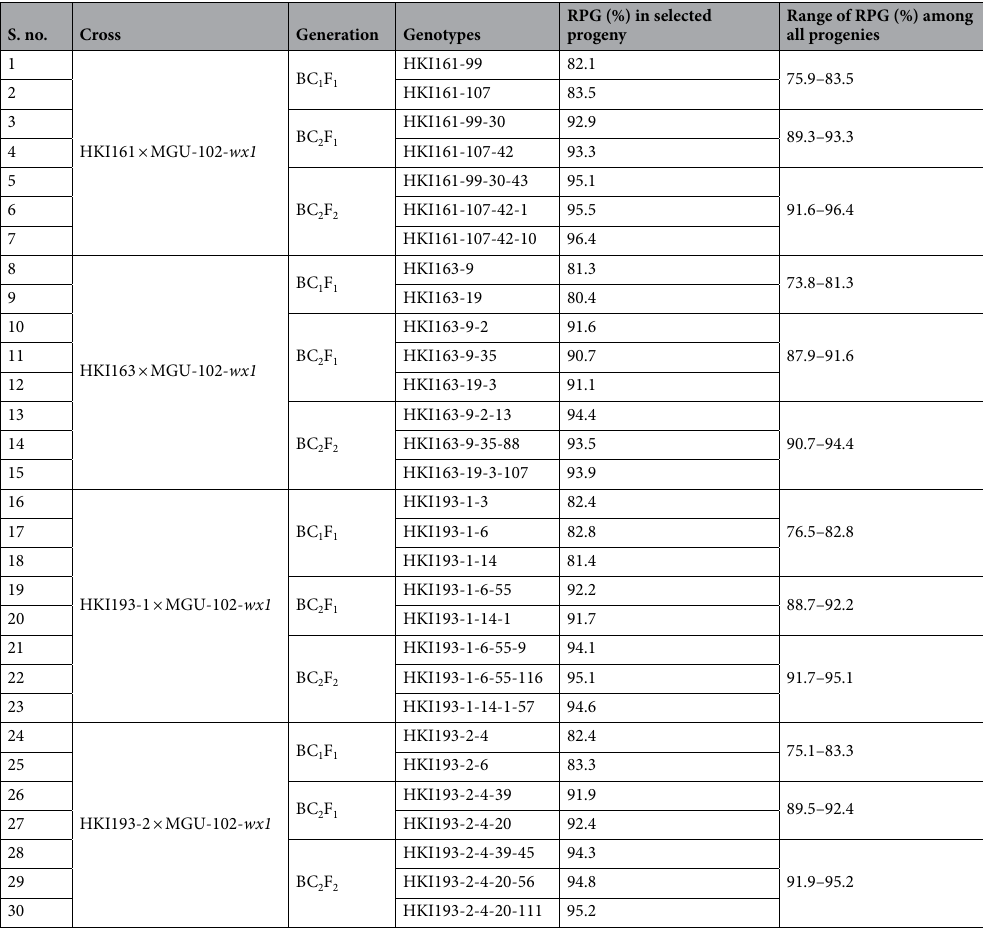
Table 3. Recovery of recurrent parent genome (RPG) among introgressed